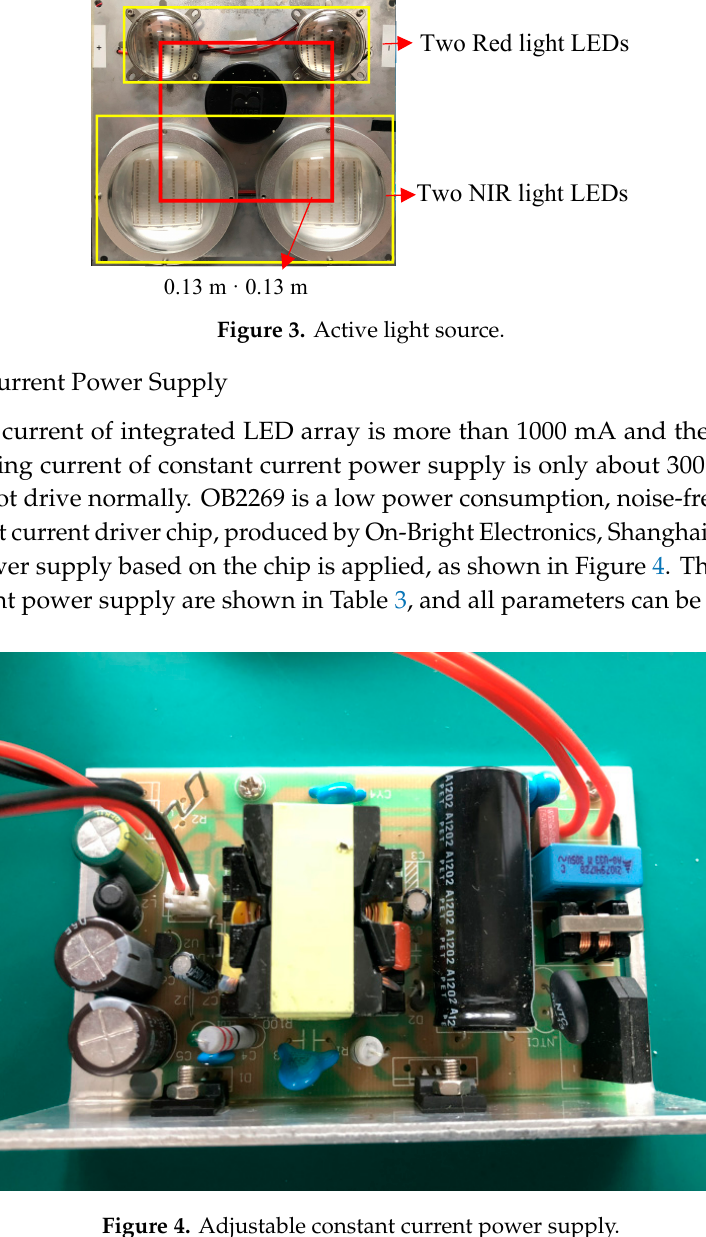
Figure 4. Adjustable constant current power supply. Table 3. Specifications of the constant current source.